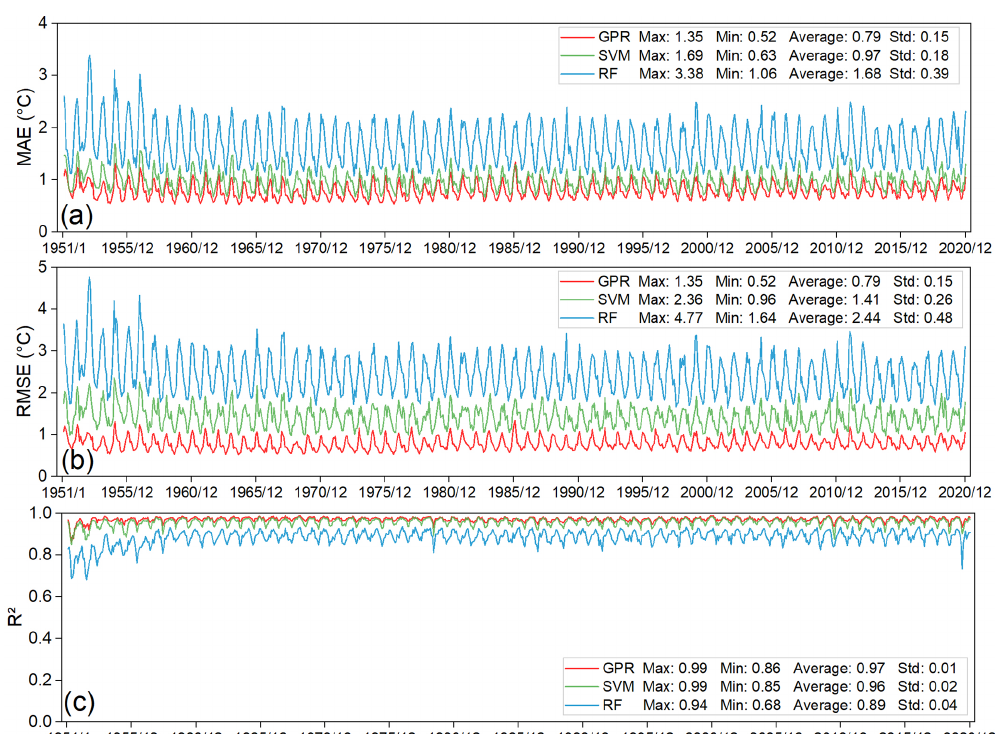
Figure 3. (a) Mean absolute error (MAE), (b) root mean square error (RMSE), and (c) coefficient of determination ( R 2 ) between observed Tmean and predicted Tmean by the three machine learning models (GPR, SVM, RF) of the test meteorological stations over the period of January 1951 to December 2020. See Figs. S4 and S5 for the accuracy graph of Tmax and Tmin.